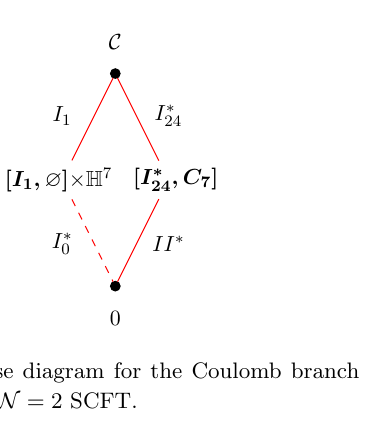
Figure 24. Information about the sp (7) 9